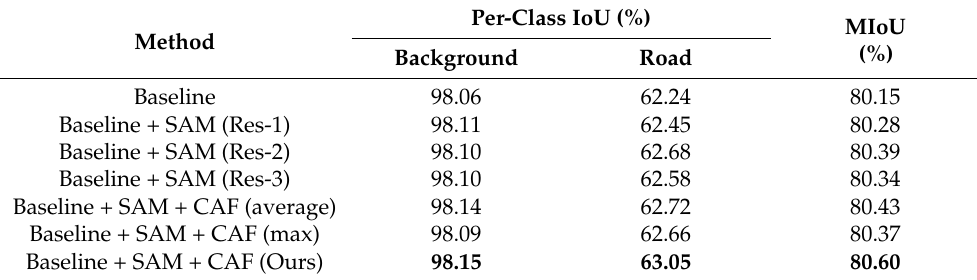
Table 5. Module validity analysis based on the DeepGlobe dataset. (Data in bold are the best results.)